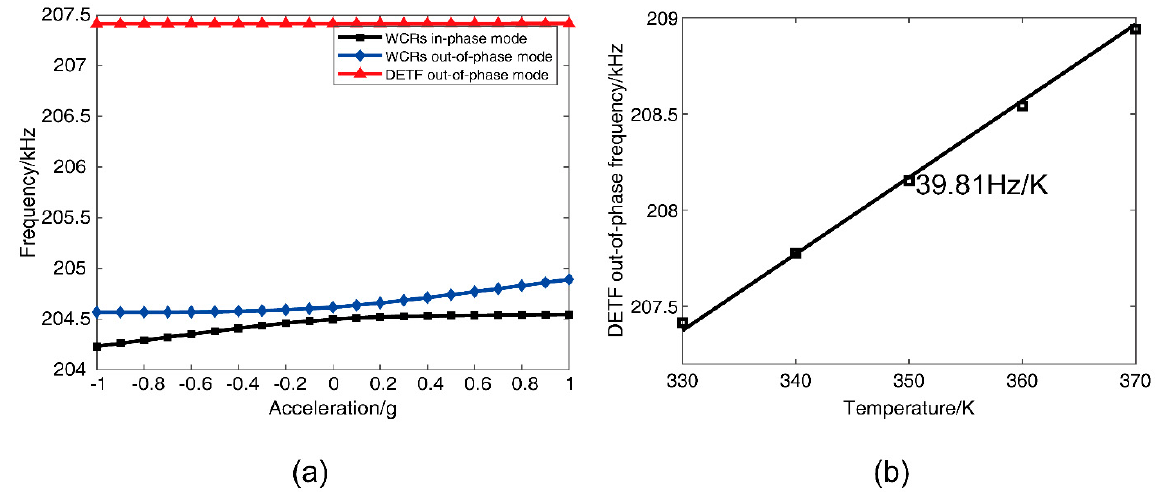
Figure 6. ( a ) The simulation results of the DETF-CC WCRs three mode frequency shift with the acceleration from – 1 g to +1 g (the effective perturbation stiffness 𝛿𝑘 = ∆𝑘/𝑘 is from − 0.005 to +0.005); ( b ) the frequency of DETF out-of-phase versus temperature at 0 g.